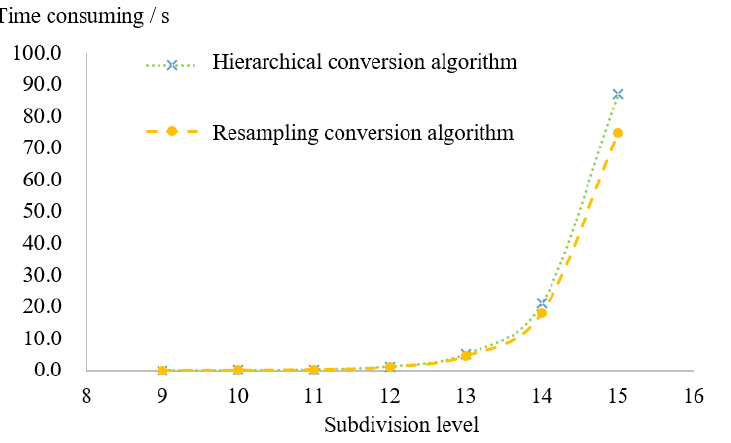
Figure 24. Efficiency of hierarchical conversion algorithms for different types of encoding.